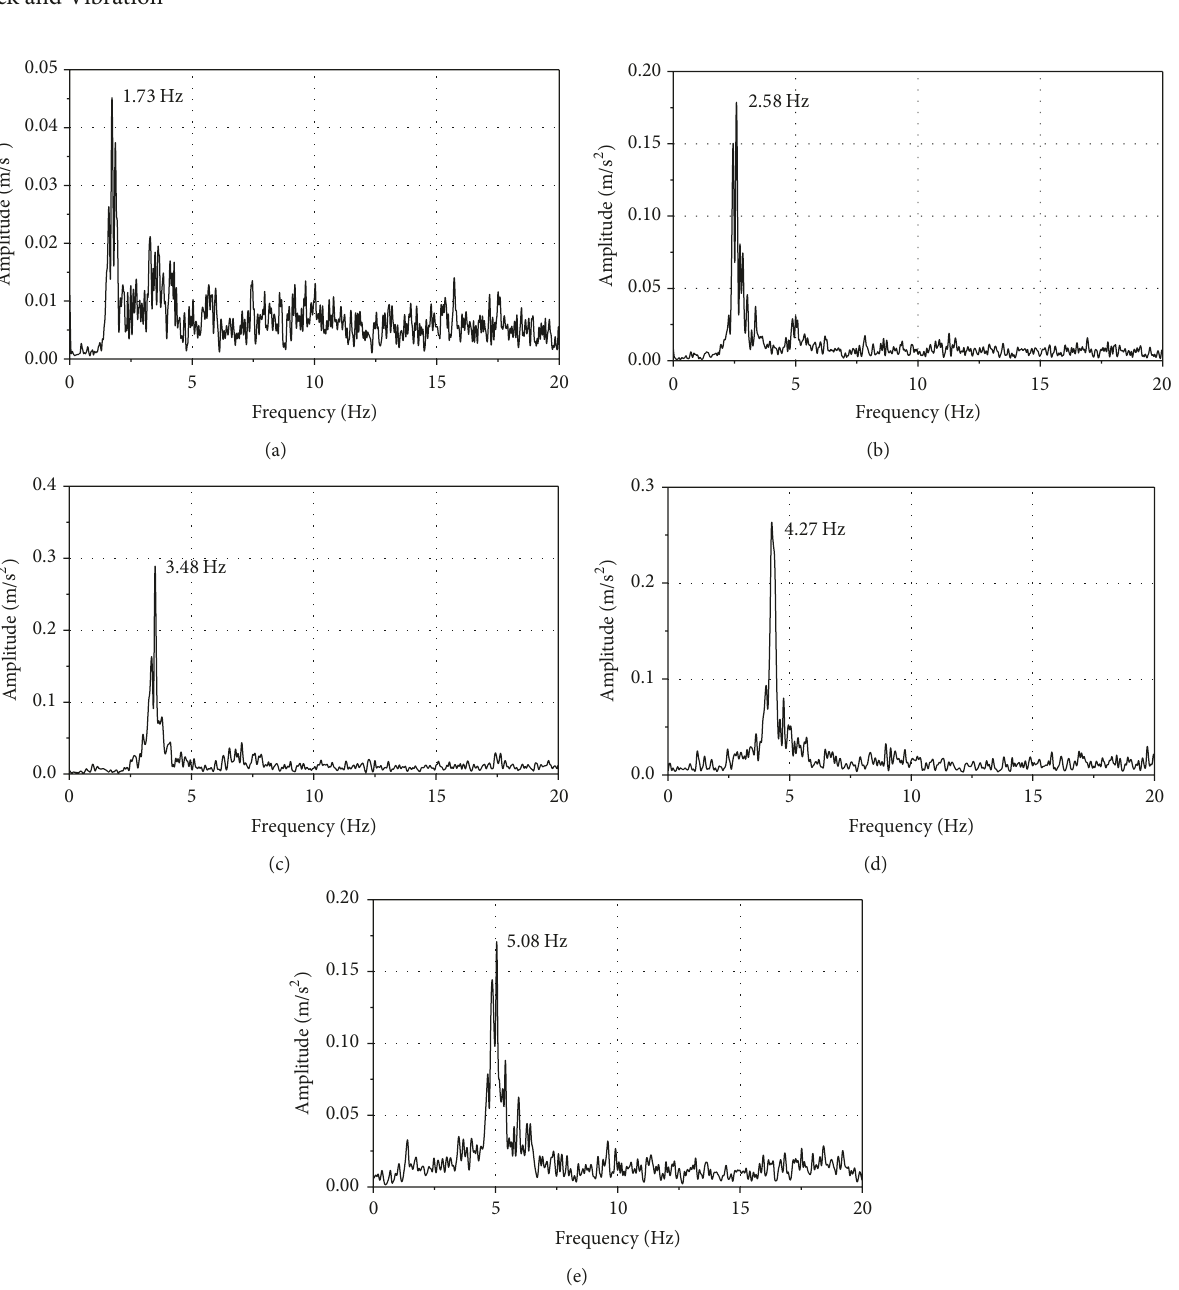
Figure 3: The frequency spectrum of the measured acceleration at different speeds: (a) 10km/h, (b) 15km/h, (c) 20km/h, (d) 25 km/h, and (e) 30 km/h.